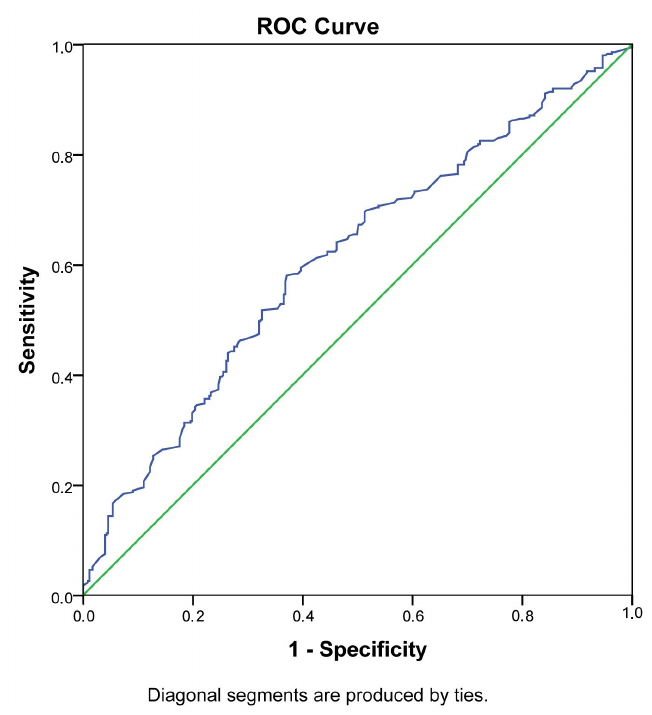
Figure 2. ROC curve of PlGF in the prediction and diagnosis of thyroid dysfunction.